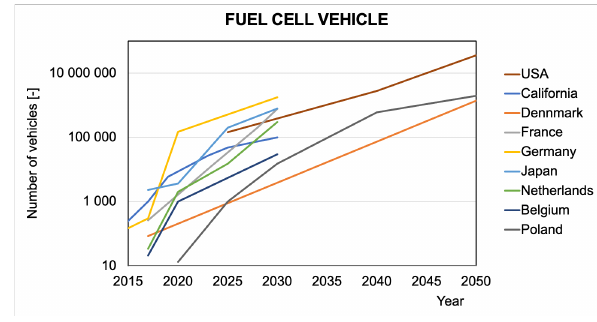
Figure 3: Actual and assumed number of FCEV in